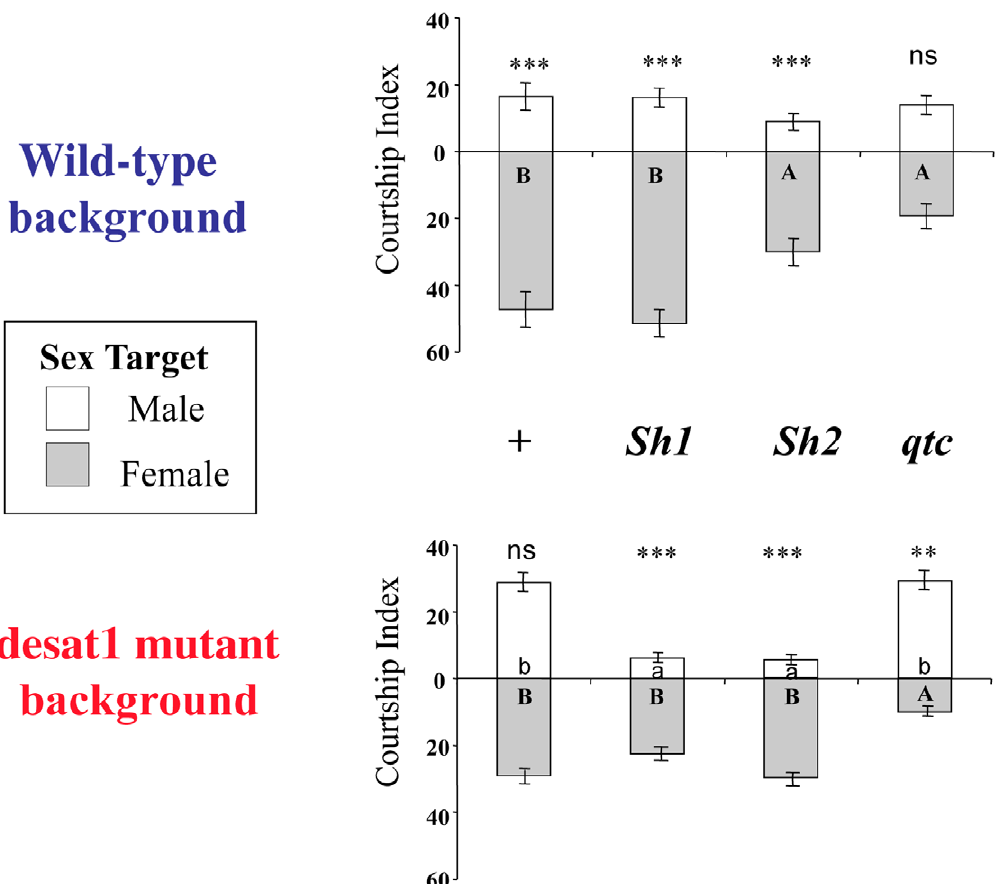
Figure 4. Behavioral effect of genetic mutations in two genetic backgrounds. The effect of mutations of the two genes Shaker ( Sh ) and quick-to-court ( qtc ) on males’ ability to discriminate wild-type target males (empty bars) and females (filled bars) was measured. Histograms represent the intensity of courtship directed towards each sex-target. The effect of the qtc mutation and of two Sh mutations ( Sh1 , Sh2 ) was measured in wild- type (top) and desat1 backgrounds (bottom). The significance of the difference in discrimination ability is represented above each bar. The different letters inside the bars (capital for female targets, lower case for male target) indicate significant differences relative to each target. N $ 45. For all other information and statistics, refer to Figs. 1 and 2. transgenic flies (Table S1). All double mutant males (homozygous for the desat1 mutation) showed a profile similar to desat1 mutant males, whereas all other single mutant and transgenic males